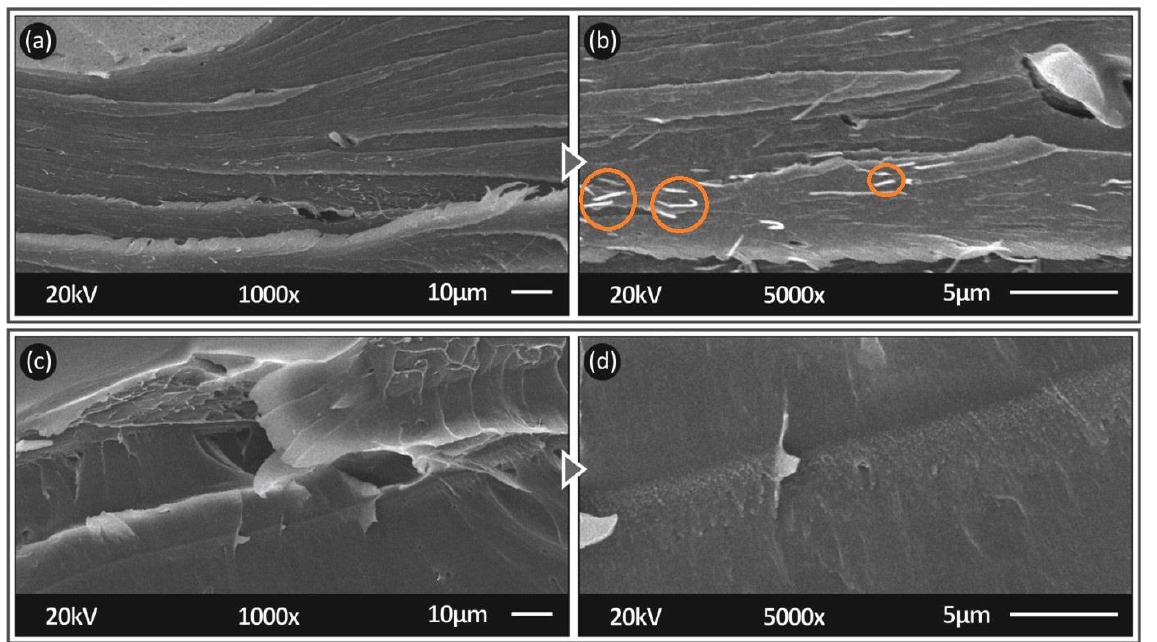
Figure 10. SEM images of the tensile specimens’ fracture area: ( a ) PC/CNF 0.5 wt.% at 1000 × magnification, ( b ) PC/CNF 0.5 wt.% at 5000 × magnification, ( c ) PC/CNF 1.0 wt.% at 1000 × magnification, ( d ) PC/CNF 1.0 wt.% at 5000 × magnification, the CNFs are highlighted in the